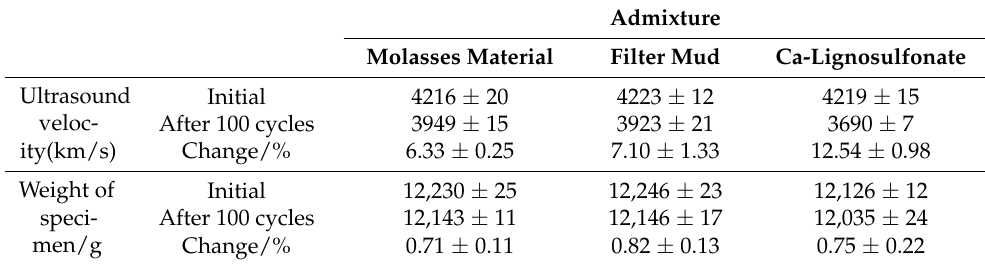
Table 6. The changes of ultrasound velocity and weight of concretes under freezing–thawing cycles.